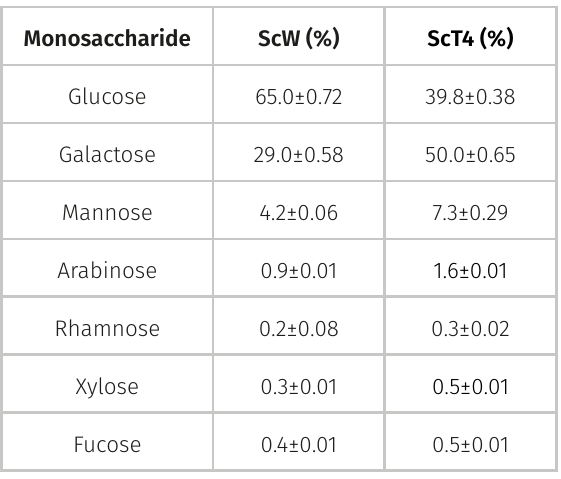
Table III. Monosaccharide composition of the hot- extracted polysaccharides of wild (ScW) and mutant (ScT4) S. commune . Values are presented as a mean of duplicates ± standard